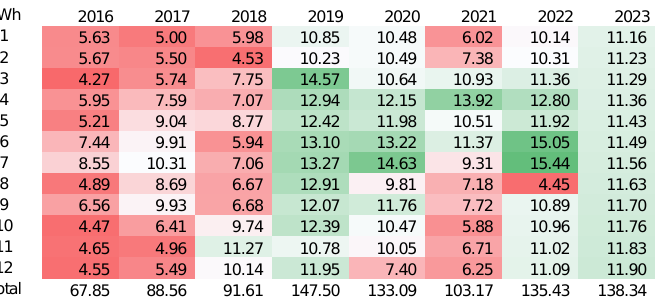
Figure 10. Neutral forecast of natural gas supply to distribution area for 2024. Forecast exercised for the period September 2022 to December 2023. These data can be found here: https://www. ec.eu- ropa.eu/ (accessed on 20 March 2022). Funding: This research received no external funding . Data Availability Statement: The data can be downloaded from https://transparency.entsog.eu (ac- cessed on March 2022). Conflicts of Interest: The author declares no conflict of interest. References 1.